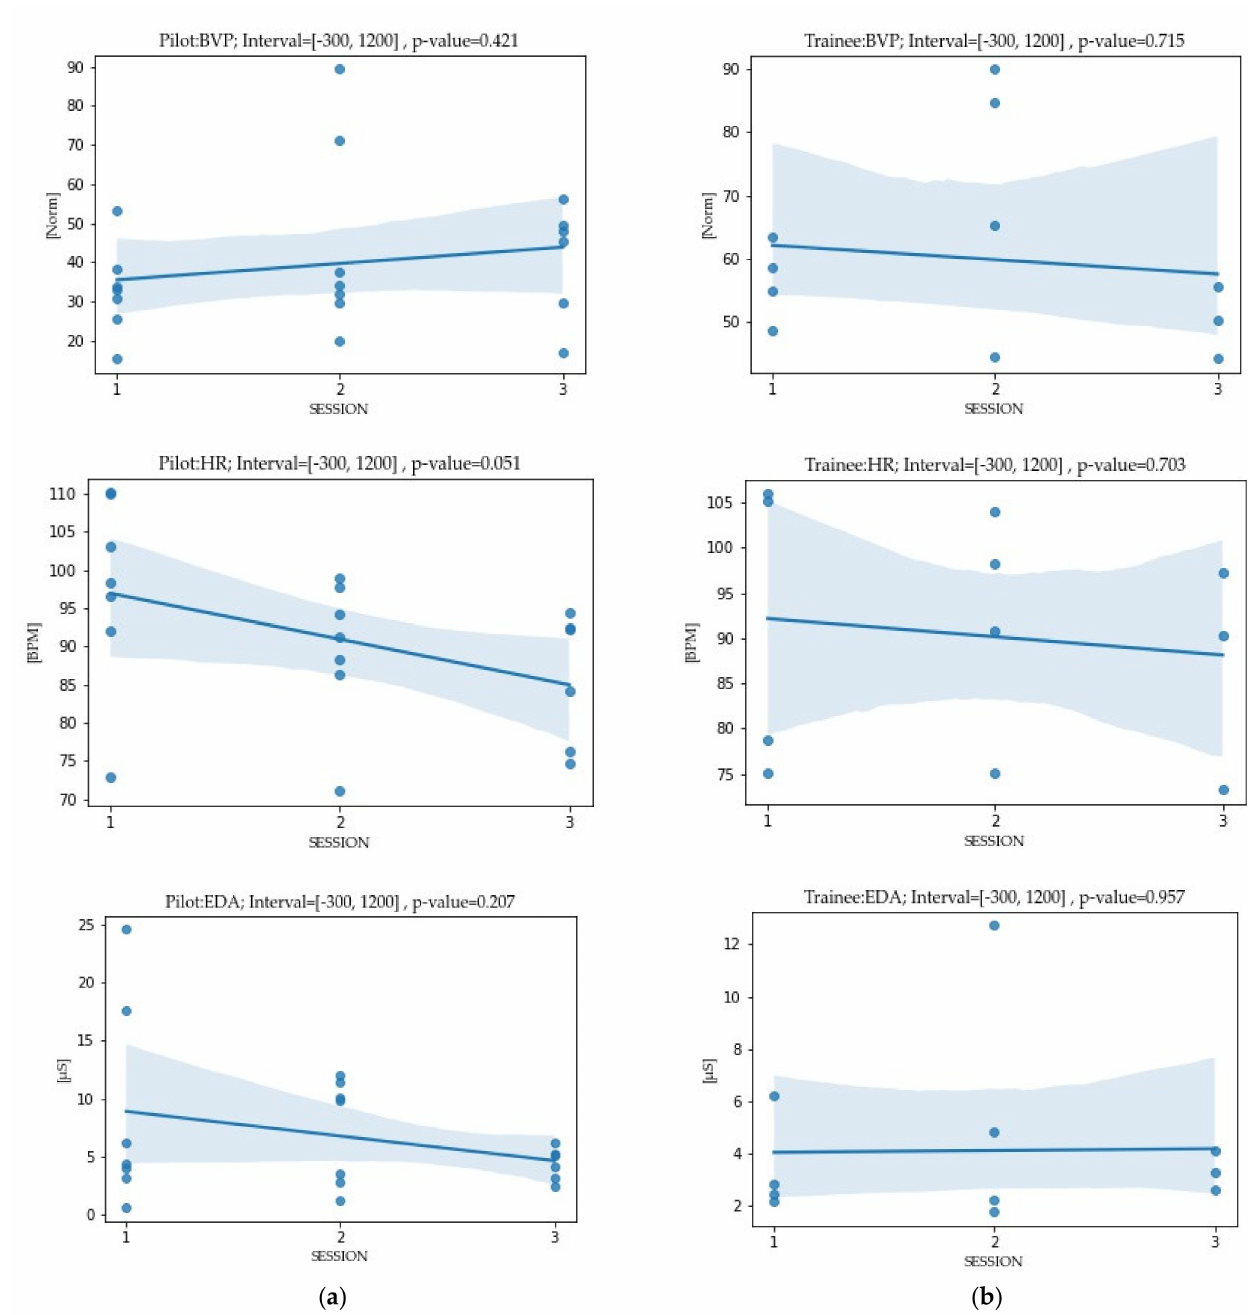
Figure 6. Mean biometrical response in the first three sessions of the experienced pilots; N = 8 ( a ) vs. trainees; N = 4 ( b ) without unexpected disturbances. The patterns of biometric response in the trainees with a lack of sea experience is different from that of the experienced ones. To control for individuals’ entering a biometrical state, the observing interval is chosen from − 300 s to 1200 s of the first three sessions, where time zero represents the ship’s entrance into the channel. The p -value represents the regression line’s slope. Contrary to our expectations, the significant differences were not satisfactorily